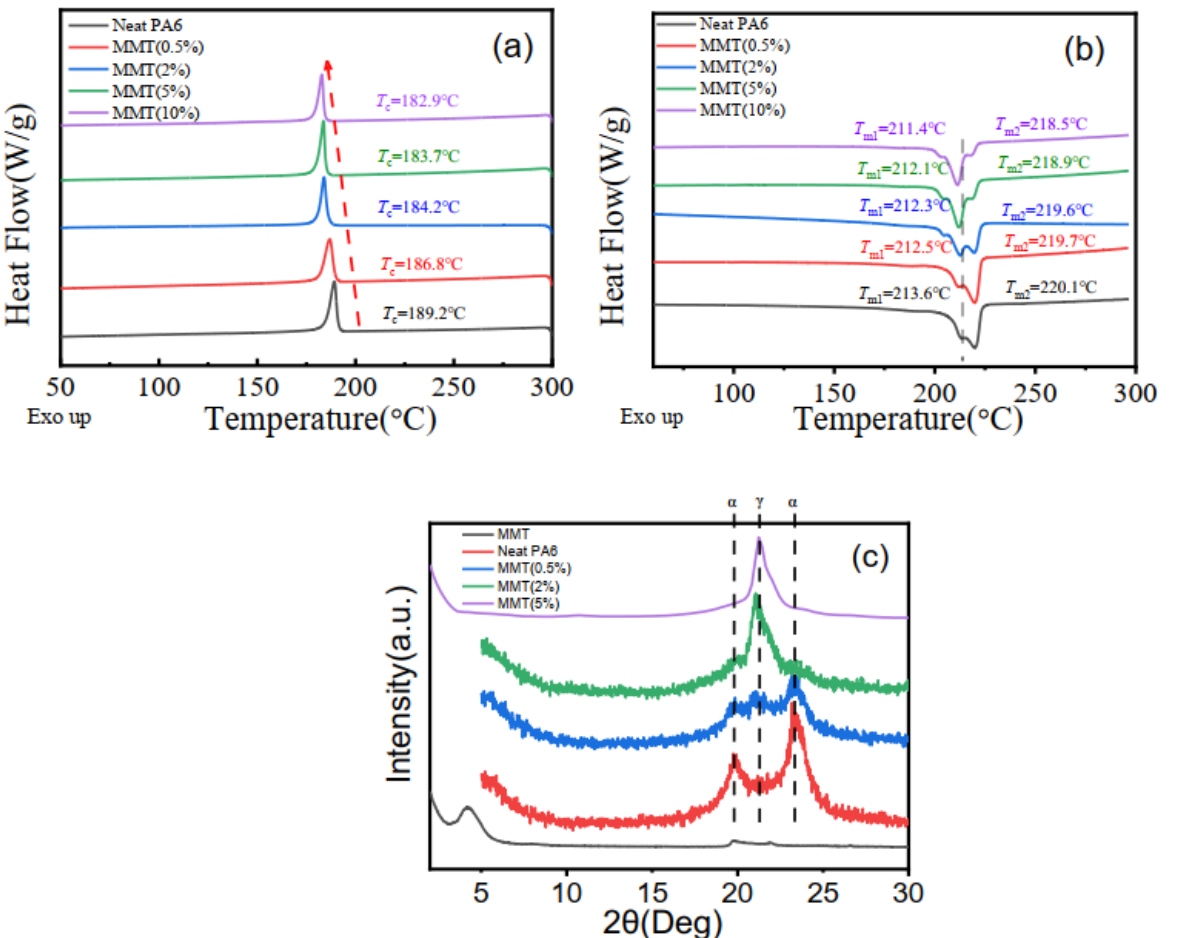
Figure 2. ( a ) DSC cooling curves (the red dashed line to show the trend of peak shift) and ( b ) heating curves of neat nylon 6 and nylon 6/montmorillonite composites with different montmorillonite loadings. The grey dashed line is used to guide the trend of peak shift ( c ) XRD patterns of neat nylon 6 and the nylon 6/montmorillonite composites.